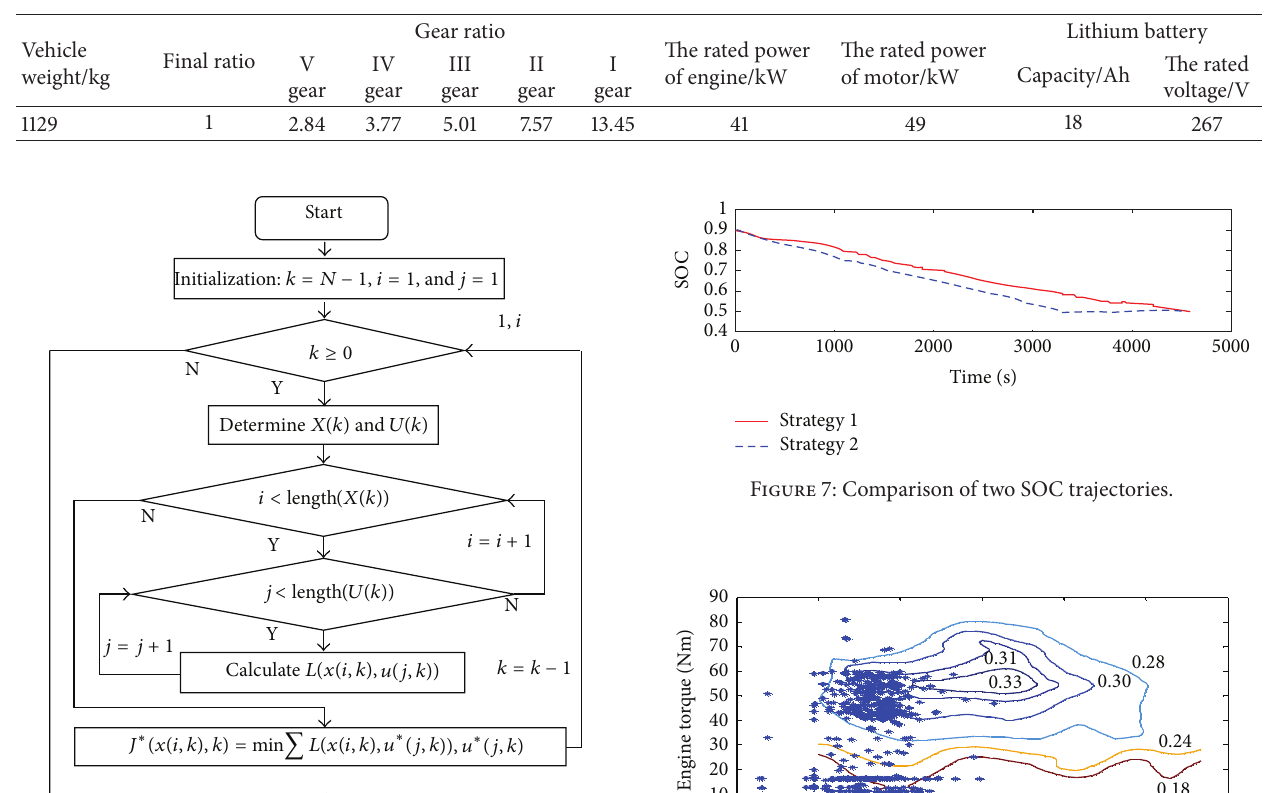
Table 1: The major parameters of plugin hybrid electric vehicle.